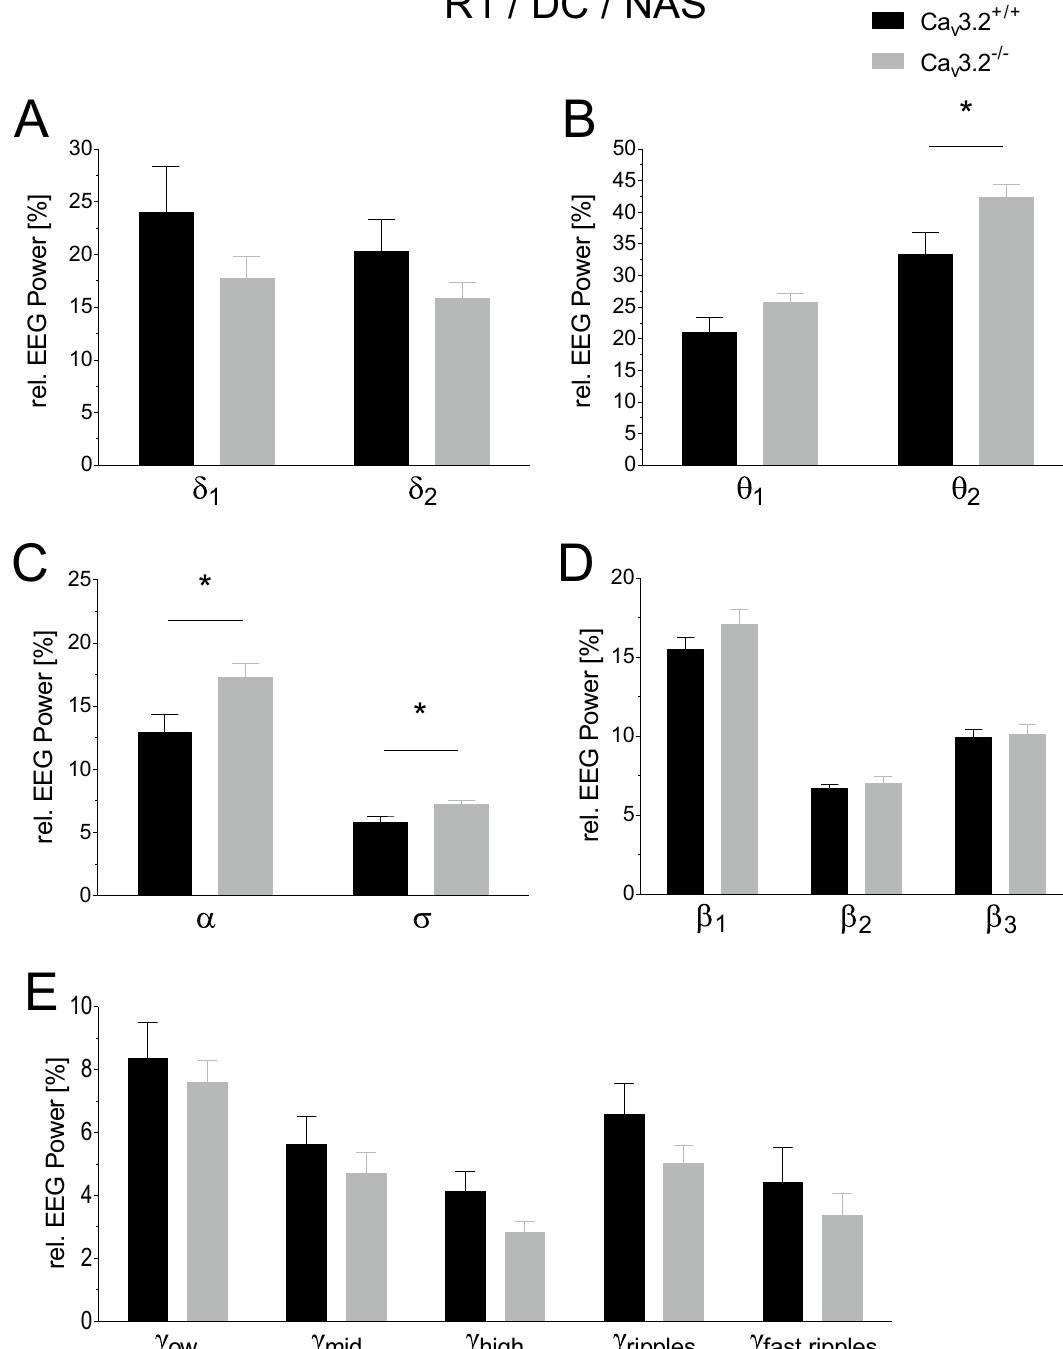
Figure 7. EEG power analysis during the non-active dark cycle state (24 h long-term recording R1) in Ca v 3.2 +/+ and Ca v 3.2 −/− mice. Relative EEG power (%) for Ca v 3.2 +/+ and Ca v 3.2 −/− animals is displayed for the individual frequency ranges ( A – E ). In Ca v 3.2 −/− mice, significant increases were observed in θ 2 , α and σ relative power ( B , C ). These alterations point to a functional involvement of Ca v 3.2 in type II theta